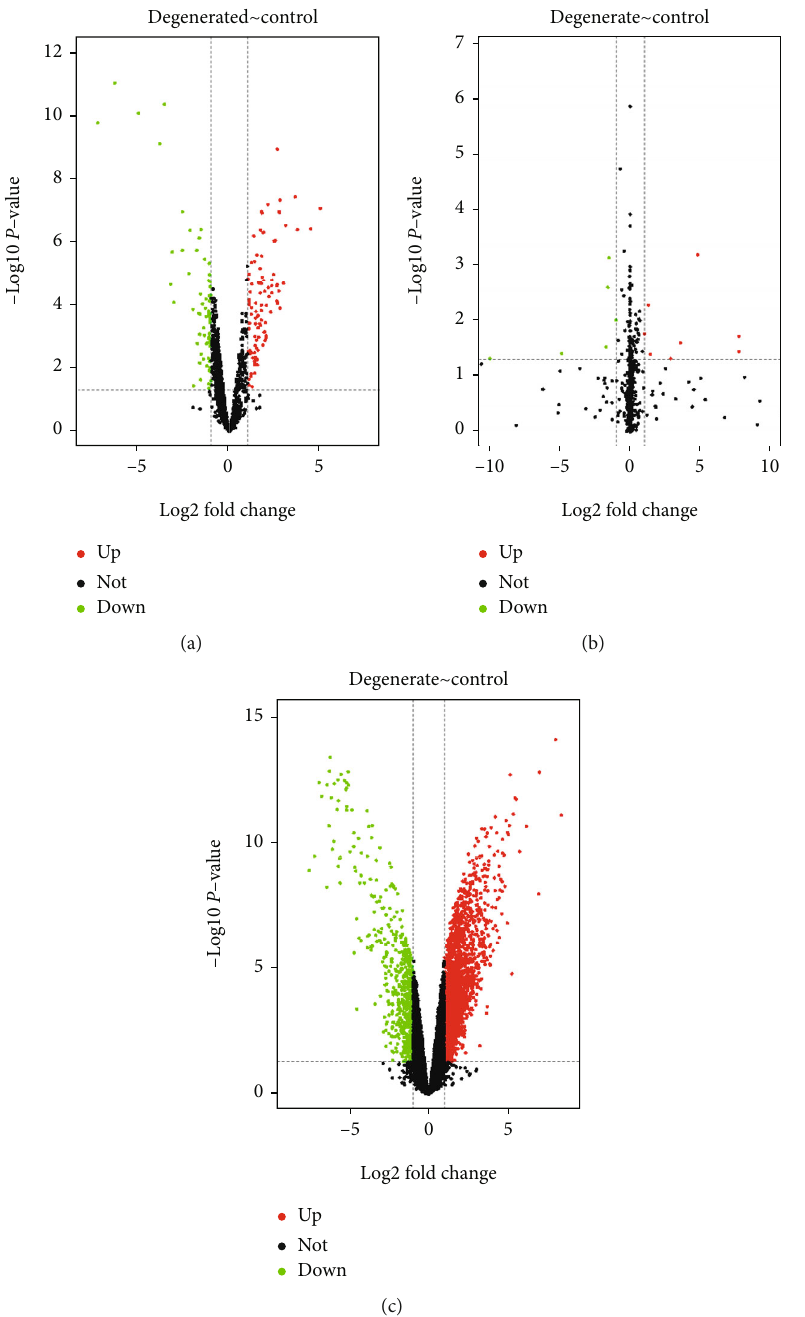
Figure 1: DEGs in the dataset. (a) Volcano map of DElncRNAs. Green represents downregulated DElncRNAs, and red represents upregulated DElncRNAs. (b) Volcano map of DEmiRNAs. Green represents downregulated DEmiRNAs, and red represents upregulated DEmiRNAs. (c) Volcano map of DEmRNAs. Green represents downregulated DEmRNAs, and red represents upregulated